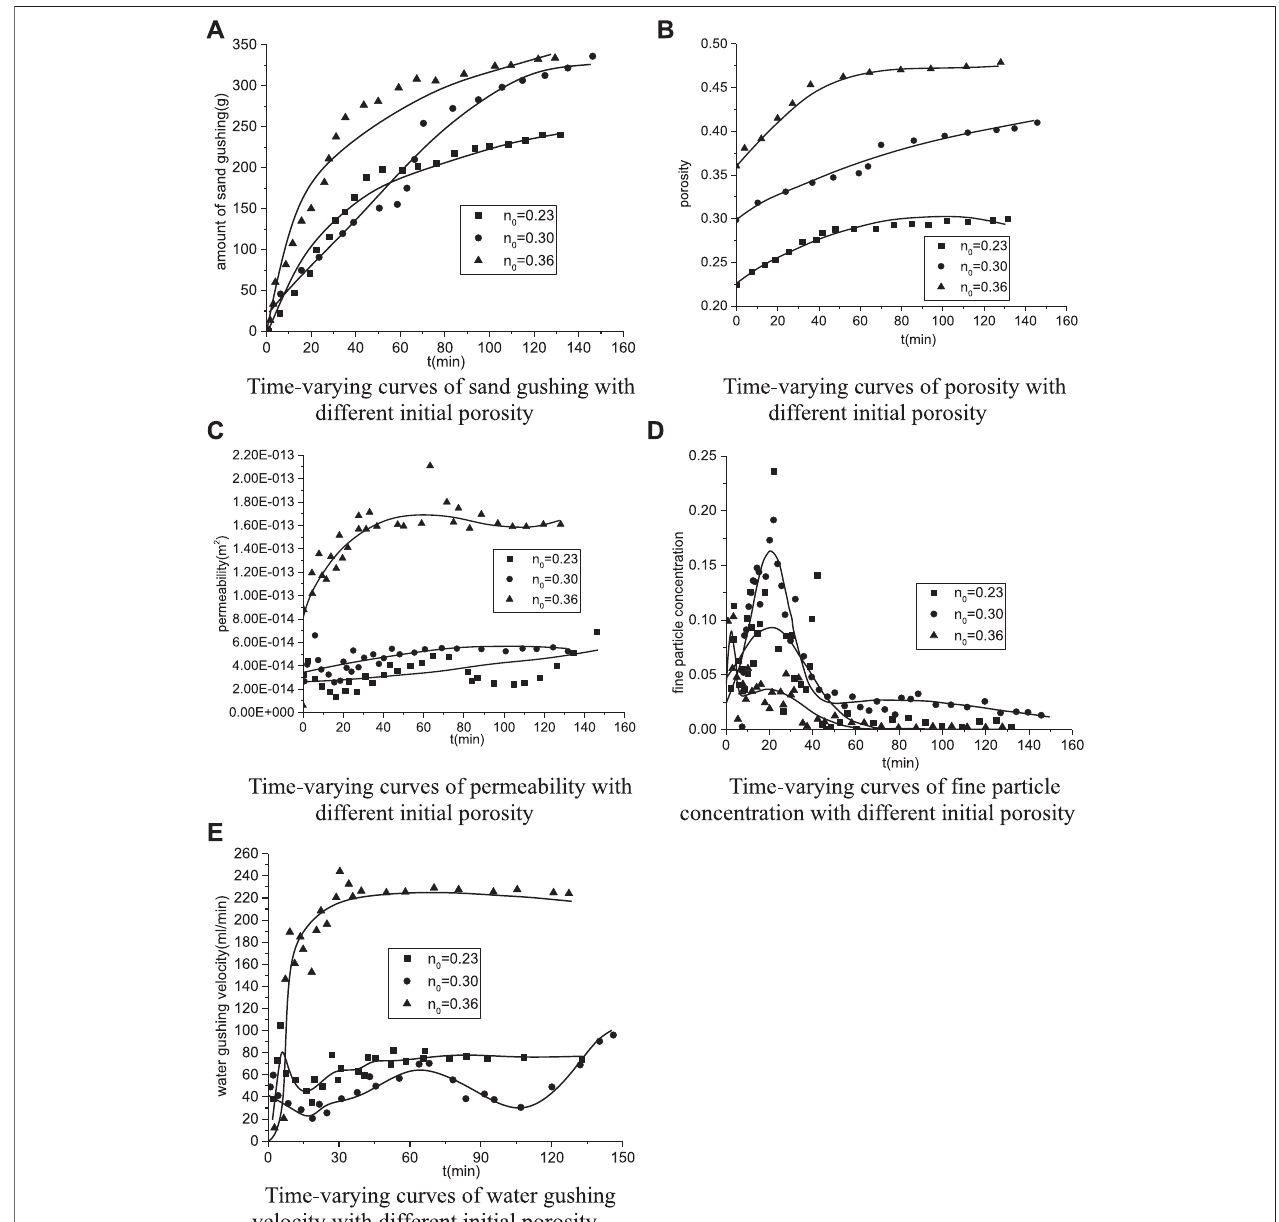
FIGURE10| In fl uenceofinitialporosityontheevolutionofwaterburstingandsandbursting: (A) time-varyingcurvesofsandgushingwithdifferentinitialporosities, (B) time-varying curves of porosity with different initial porosities, (C) time-varying curves of permeability with different initial porosities, (D) time-varying curves of fi ne particle concentration with different initial porosities, and (E) time-varying curves of water gushing velocity with different initial porosity.